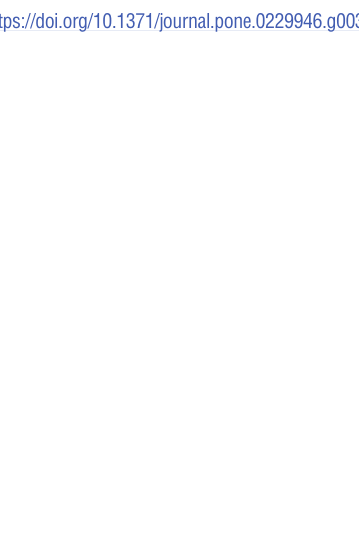
Fig 3. Geographical distribution of dental treatment rate for persons with